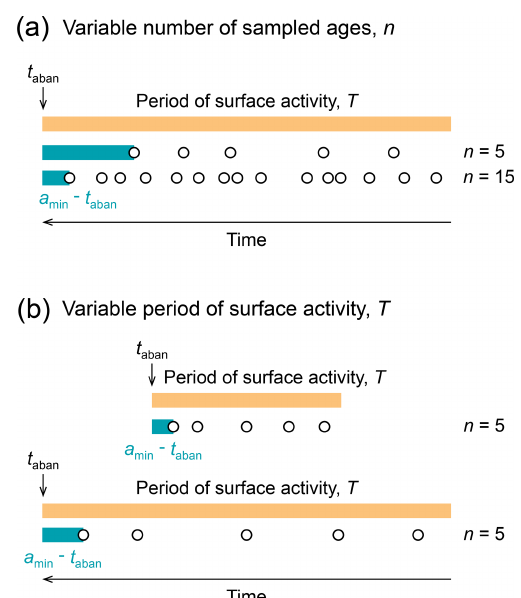
Figure 2. Schematic surface with a period of activity, T (orange bar), abandoned at t aban , and randomly sampled with n ages (cir- cles). (a) If n increases, the youngest sampled age, a min , is likely to fall closer to t aban . (b) If T increases, the youngest sampled age, a min , is likely to fall farther from t aban , even if the same number of ages are